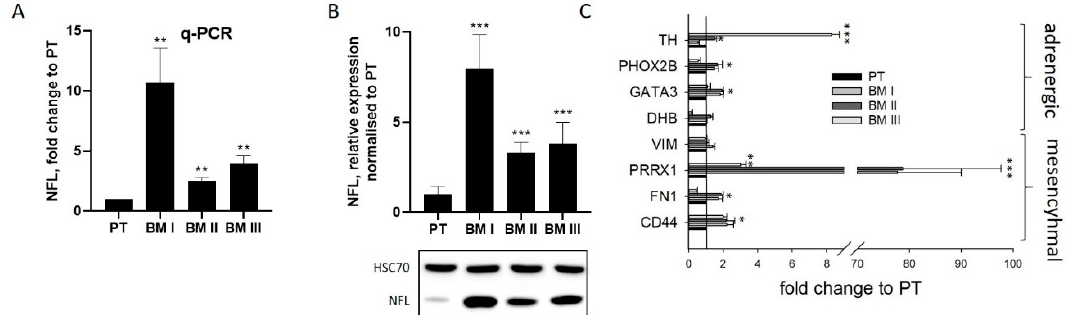
Figure 3. BM I cells show a differentiated phenotype. The levels of NFL transcripts and proteins were analyzed by real-time PCR (q-PCR, ( A )) and by Western blotting ( B ). The uncropped blots are shown in Figure S2. ( C ) Analysis of adrenergic and mesenchymal marker transcripts by q-PCR. The levels obtained for PT were set to 1. Shown are mean ± SD of three independent experiments. * p < 0.05, ** p < 0.001, *** p < 0.0001.